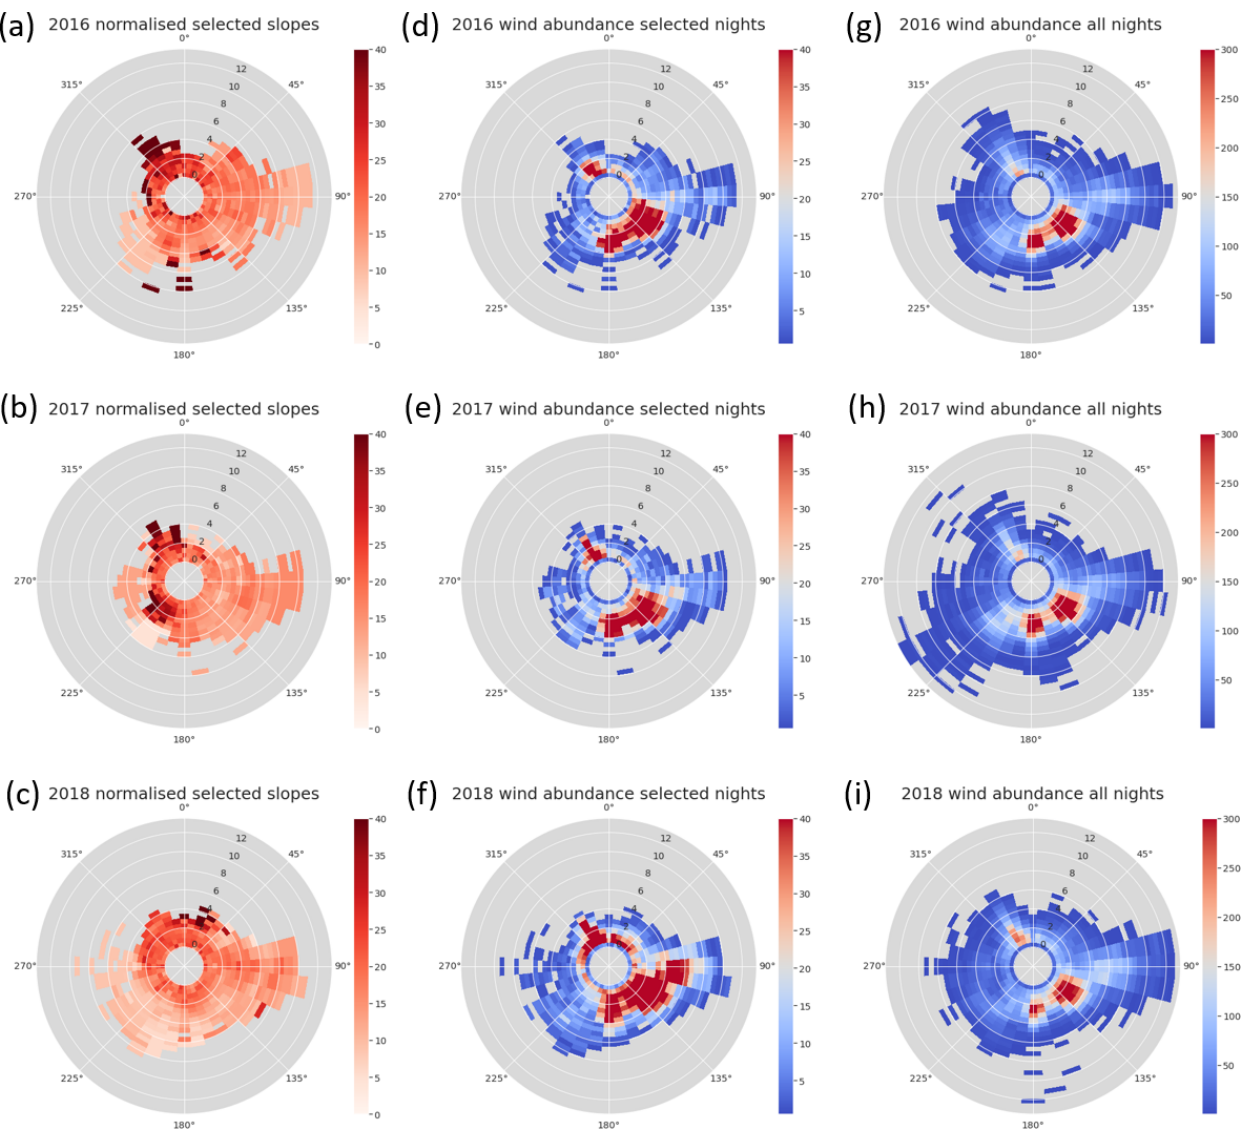
Figure 6. (a–c) Distribution of nighttime slopes (in ppb ( Bqm − 3 ) − 1 ) by local wind direction ( ◦ ) and velocity (ms − 1 ) for the years 2016, 2017, and 2018. The corresponding frequency distributions of wind direction and velocity for the selected nights are displayed in (d–f) , while the distributions for all nights of the respective year (from 21:00–04:00CET) are shown in (g–i) . It is clearly visible that wind velocities are generally lower during the selected nights than during all